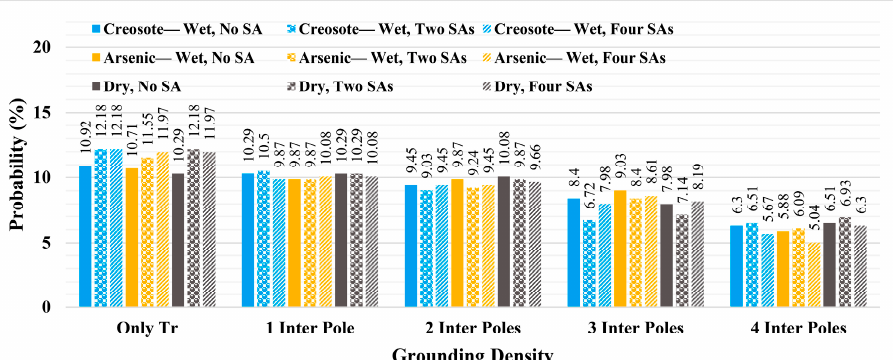
Figure 30. Comparison among the probabilities of transformers experiencing overvoltage stress above 30 kV under di ff erent grounding densities of intermediate poles (Inter Pole) and considering two and four surge arresters (SAs); Network with dry poles.